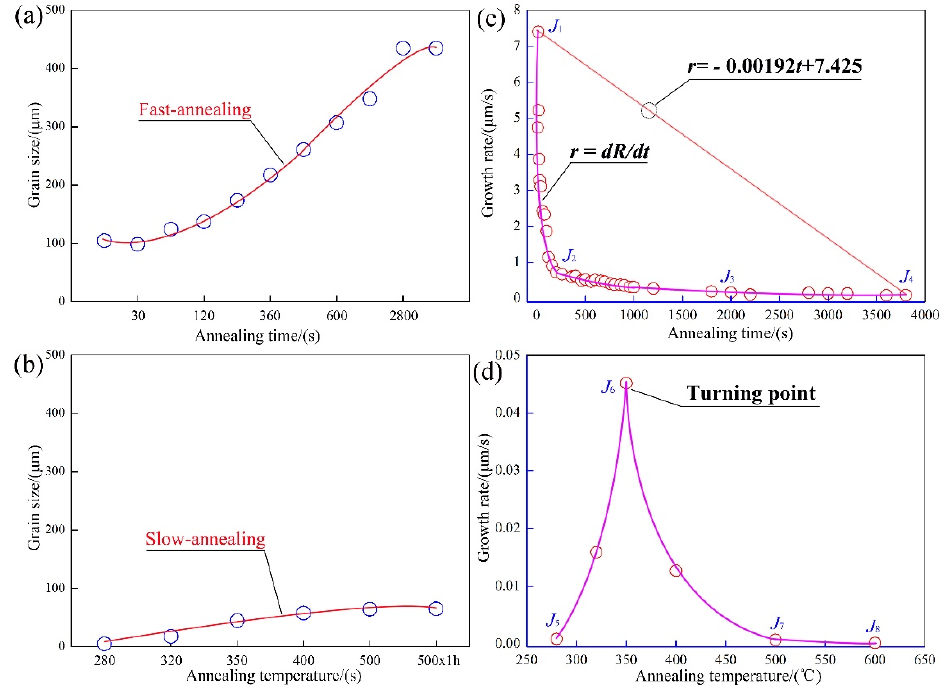
Figure 2. Grain size and grain growth rate of ( a ) fast annealing; ( b ) slow annealing; ( c , d ) grain growth rate corresponding to ( a , b ).